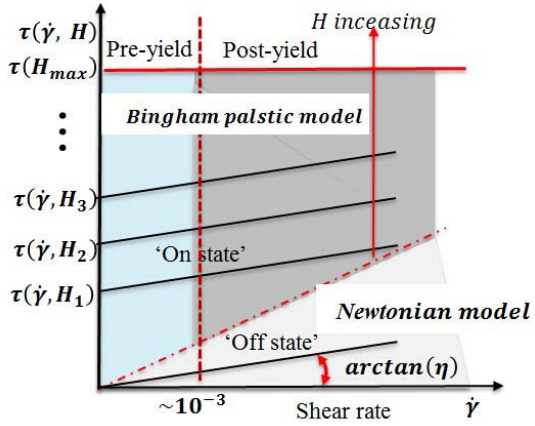
Figure 3. MR fluid’s behaviors upon external electromagnetic field.